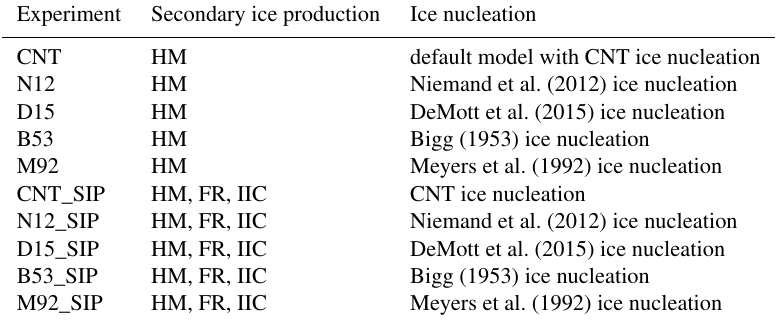
Table 1. List of model